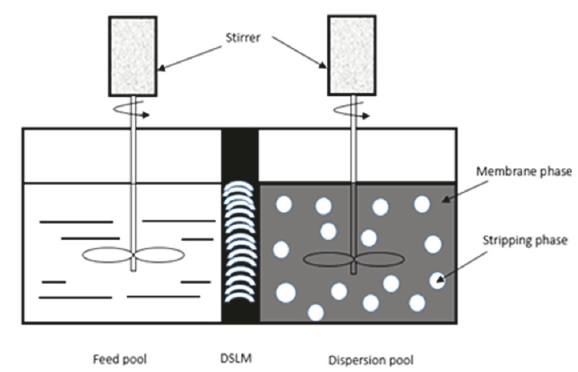
Figure 1: Schematic diagram of DSLM